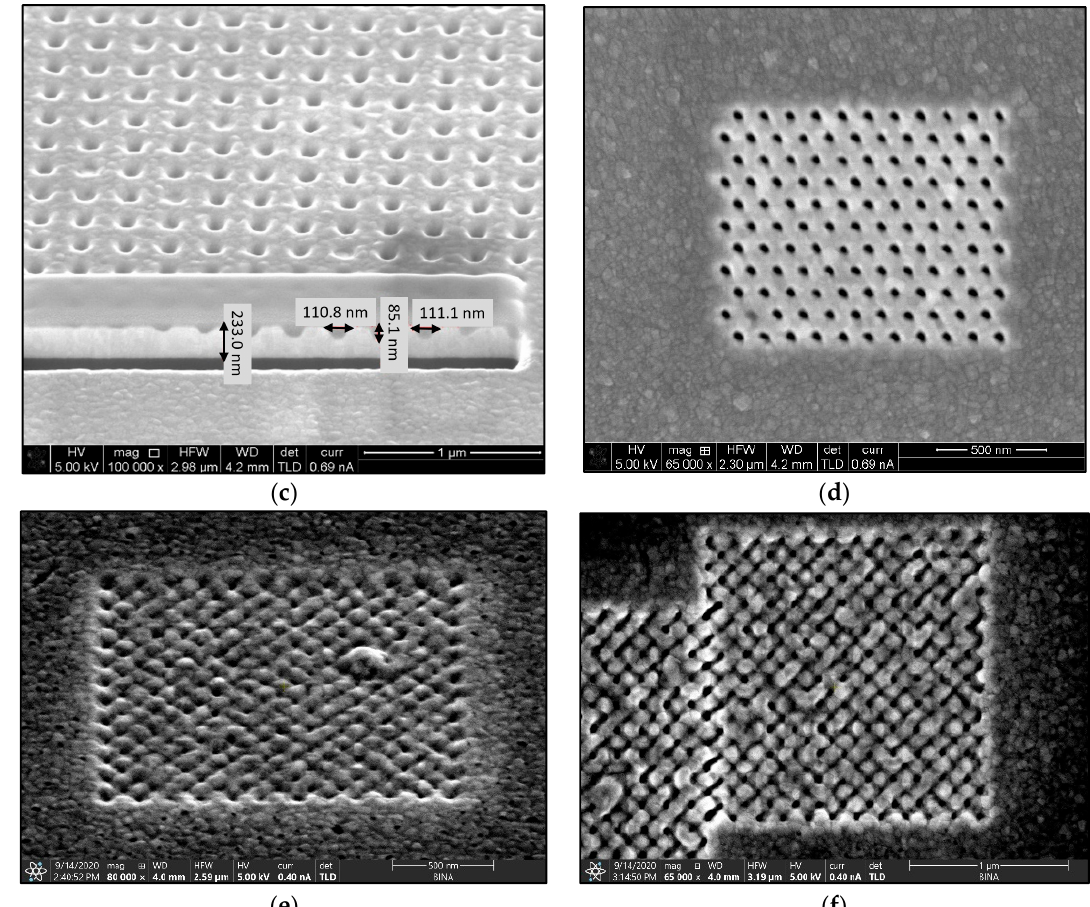
Figure 25. SEM pictures of preliminary samples fabricated with FIB technique. ( a ) Simulation mask of an array of tips before the fabrication of the protrusions; ( b ) simulation mask of holes array before the fabrication of cavities. ( c ) Nano-holes square lattice of cavities; ( d ) nano-holes hexagonal lattice of cavities; ( e ) nano-protrusions array using FIB; ( f ) nano-protrusion double-array fabrication using FIB.